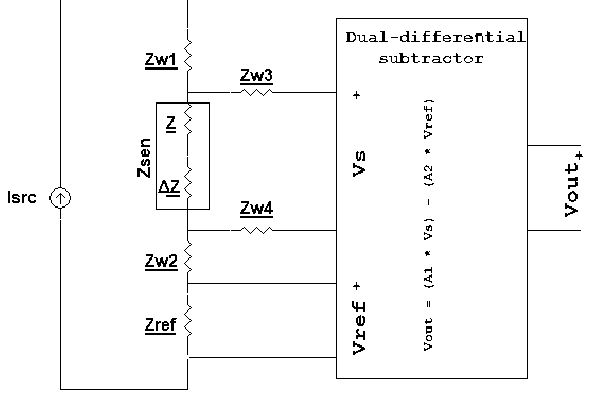
Figure 1. Anderson Figure 1. Anderson loop.